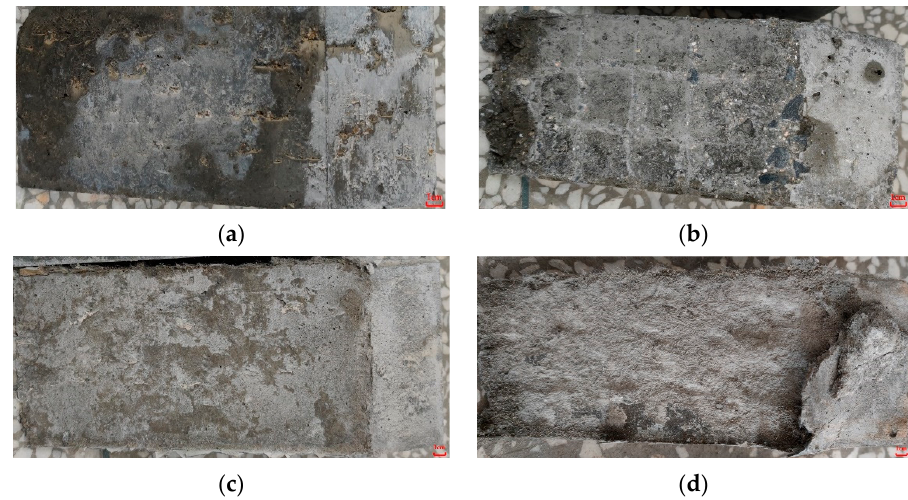
Figure 11. Interface damage status of the slant shear test specimens. ( a ) OC/OC-N; ( b ) OC/OC-Y;